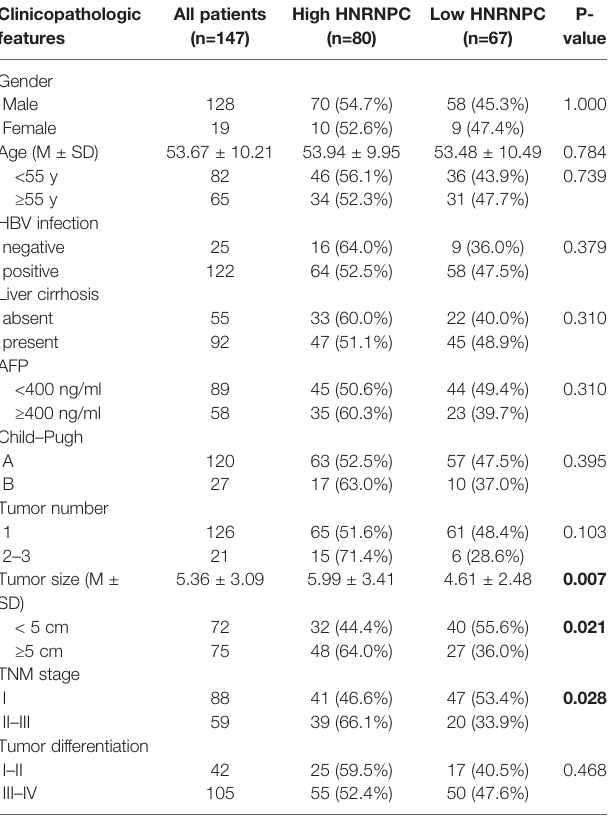
TABLE 1 | Relationships of HNRNPC protein levels with clinicopathologic features in 147 HCC patients. Clinicopathologic